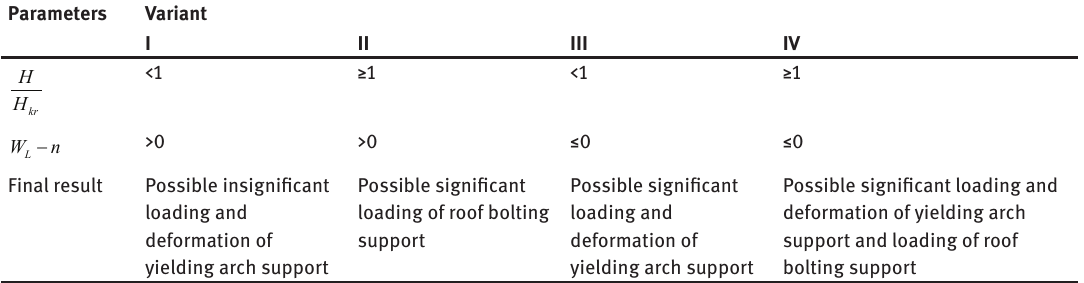
Table 3: Variants of possible support loading and deformation of mining excavations [19].